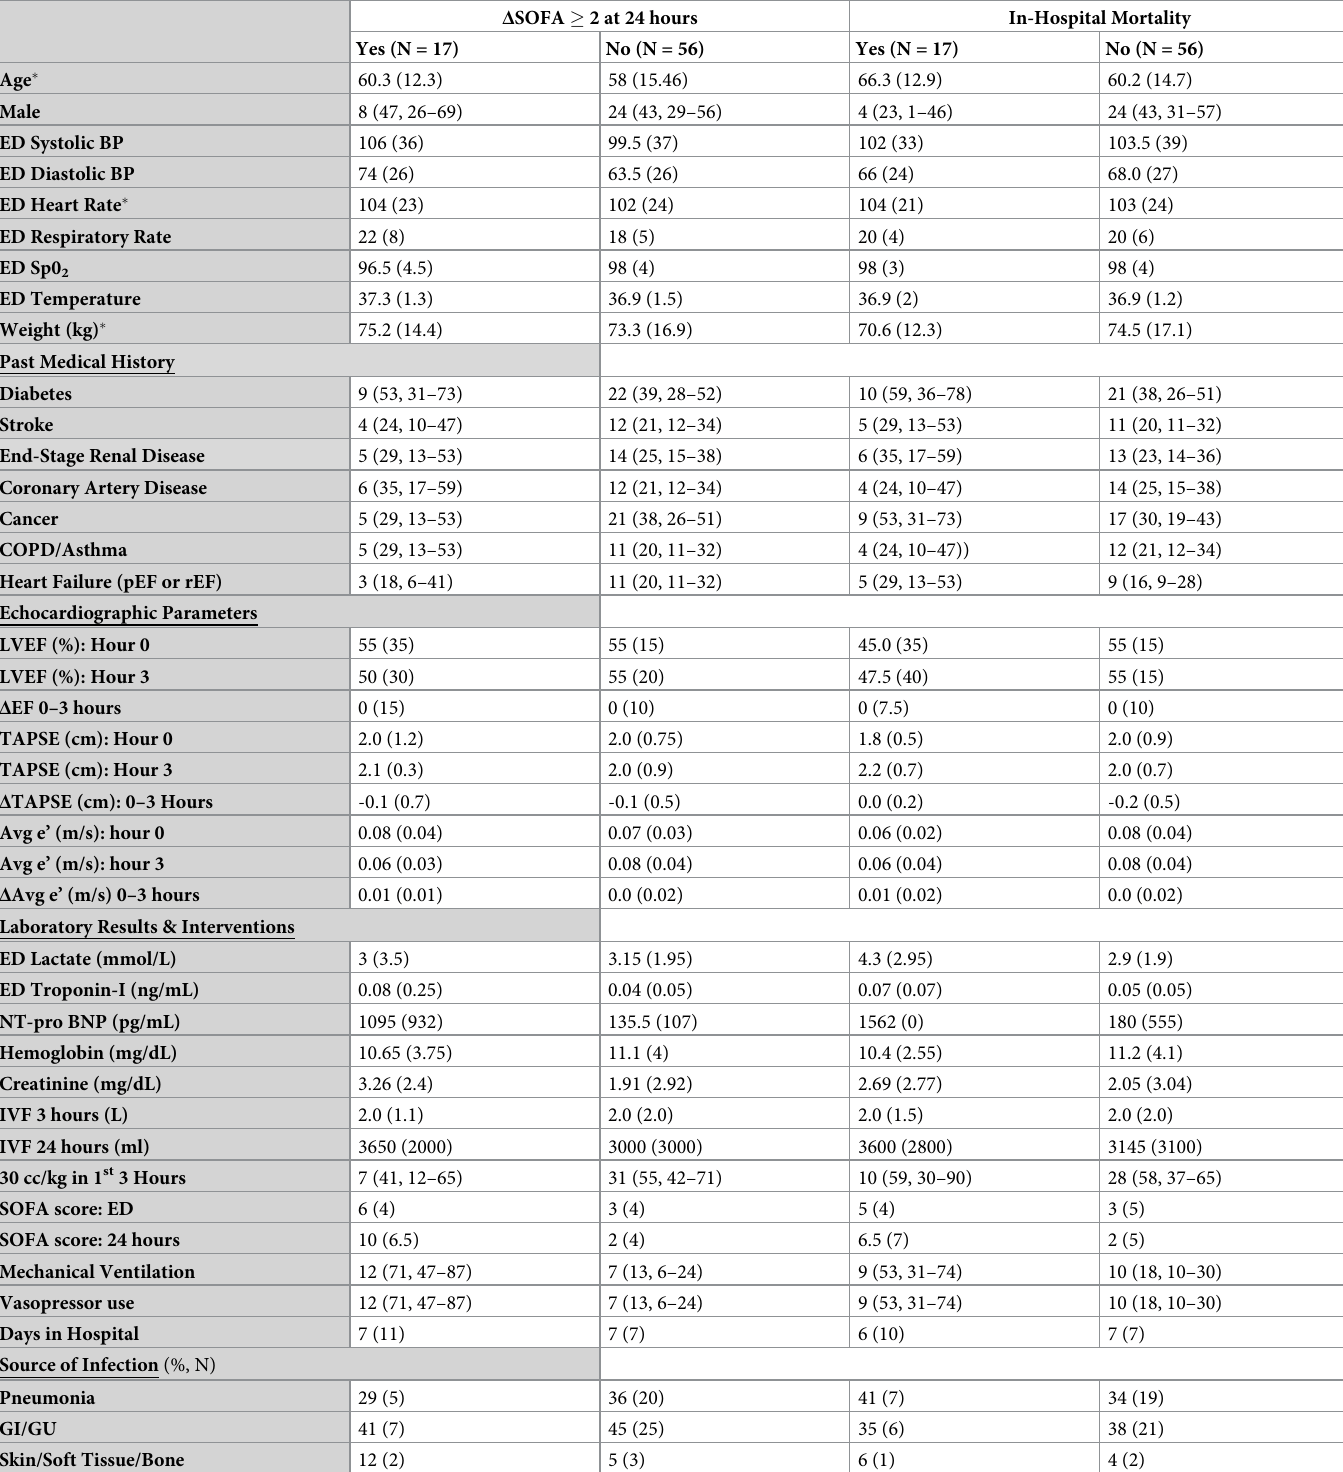
Table 1. Characteristics of study